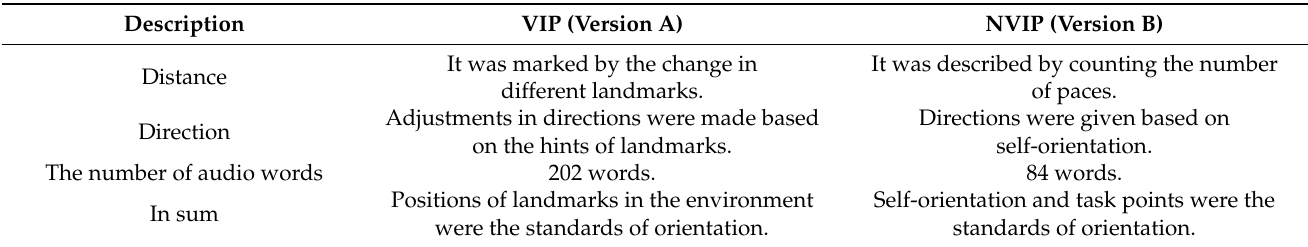
Table 1. A comparison between version A and version B.